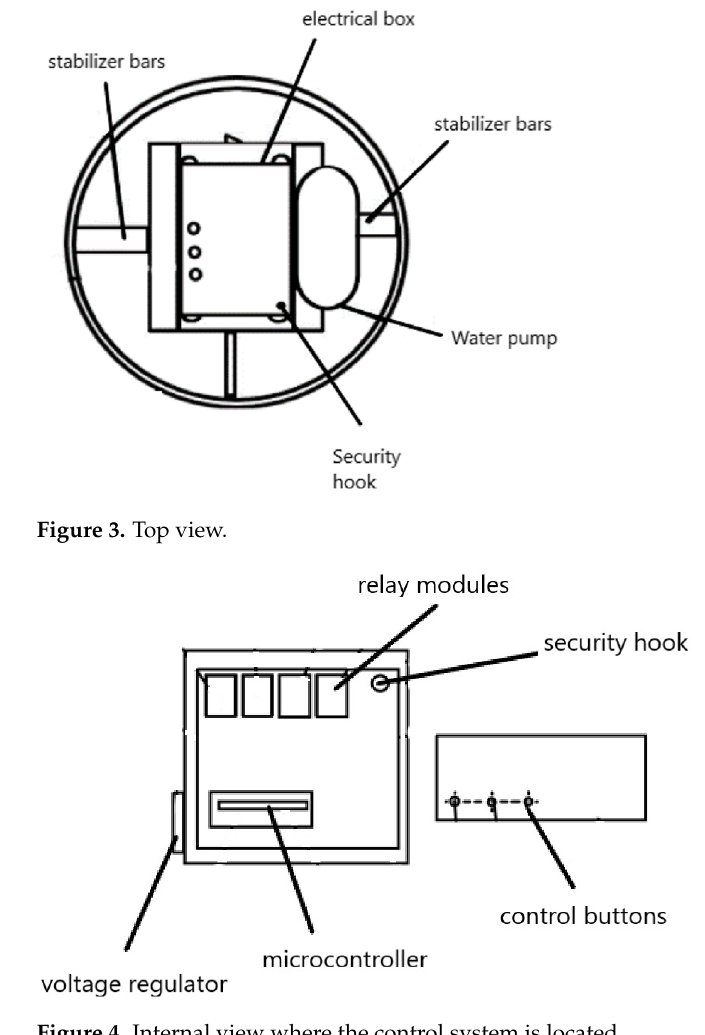
Figure 4. Internal view where the control system is located.